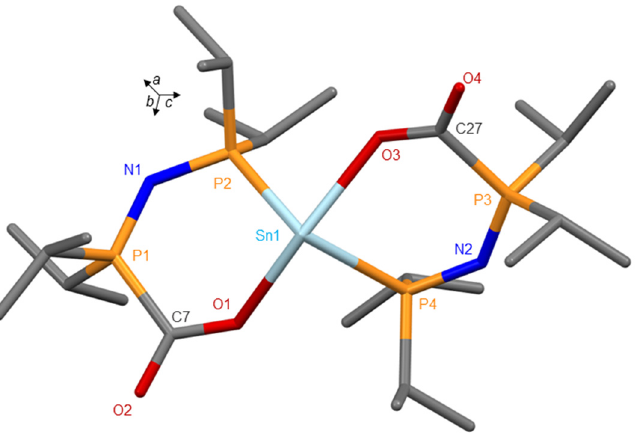
Figure 17. Molecular structure of 14 , adapted from [69] (MERCURY view). Hydrogen atoms are omitted for clarity (Sn light blue, O red, P orange, N dark blue, C grey).